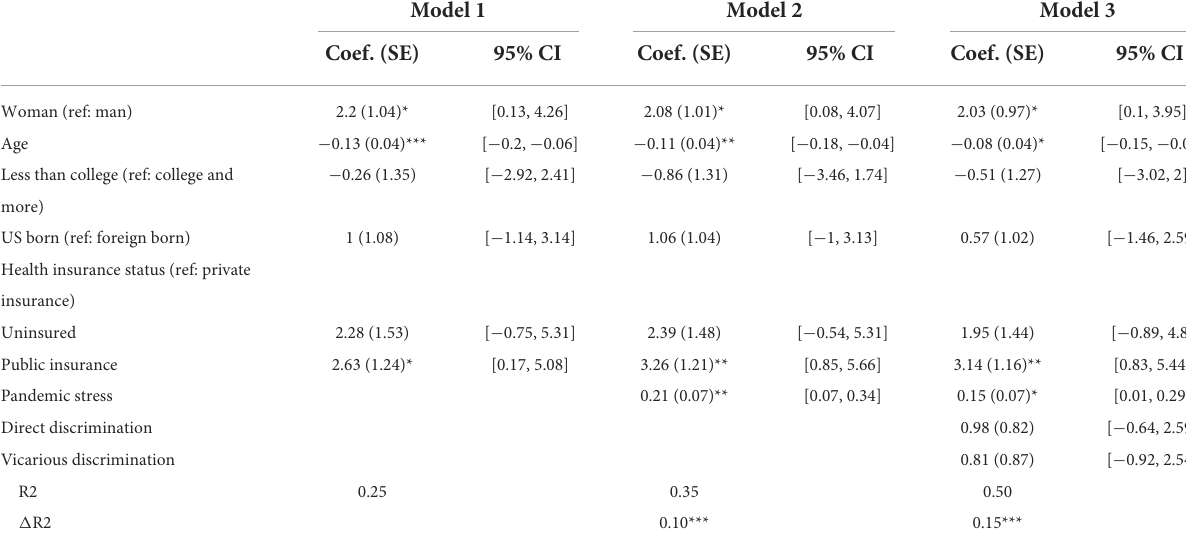
TABLE 8 Hierarchical regressions for psychological worry: South